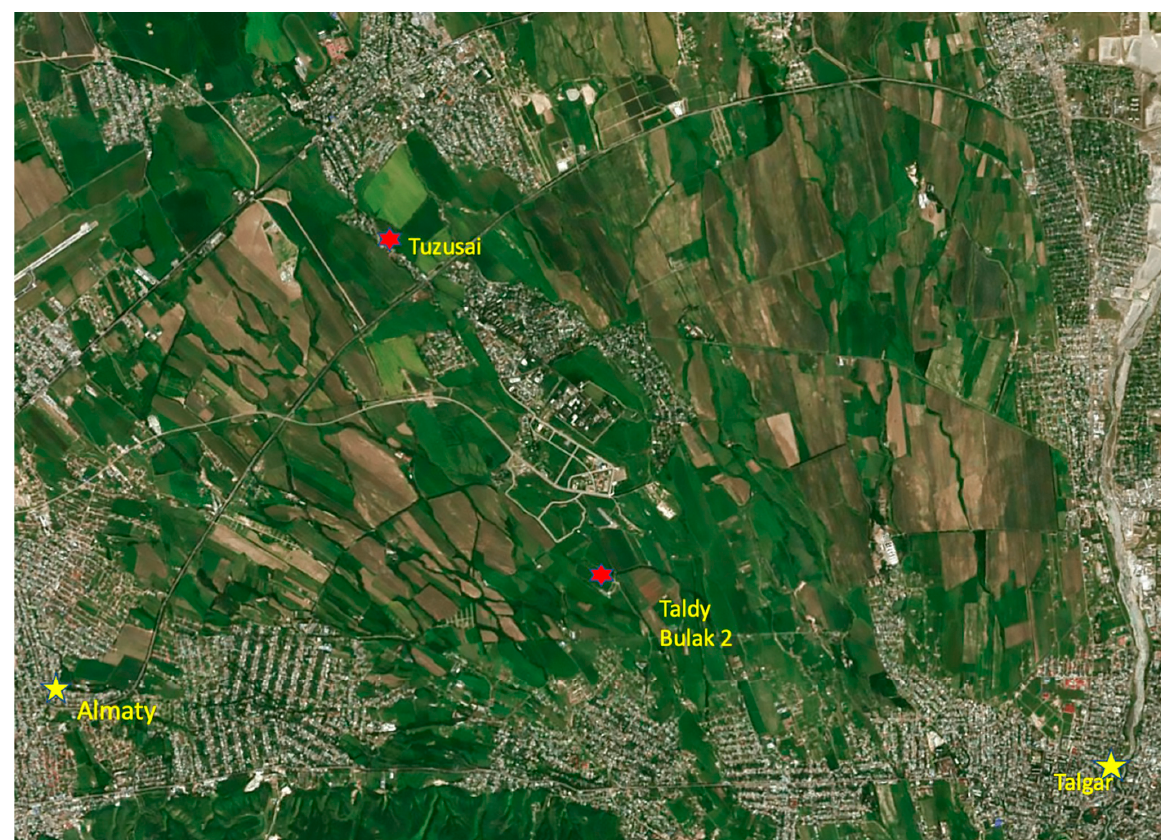
Figure 2. Google Maps image showing the Talgar fan and the location of the two settlements: Tuzusai and Taldy Bulak 2.